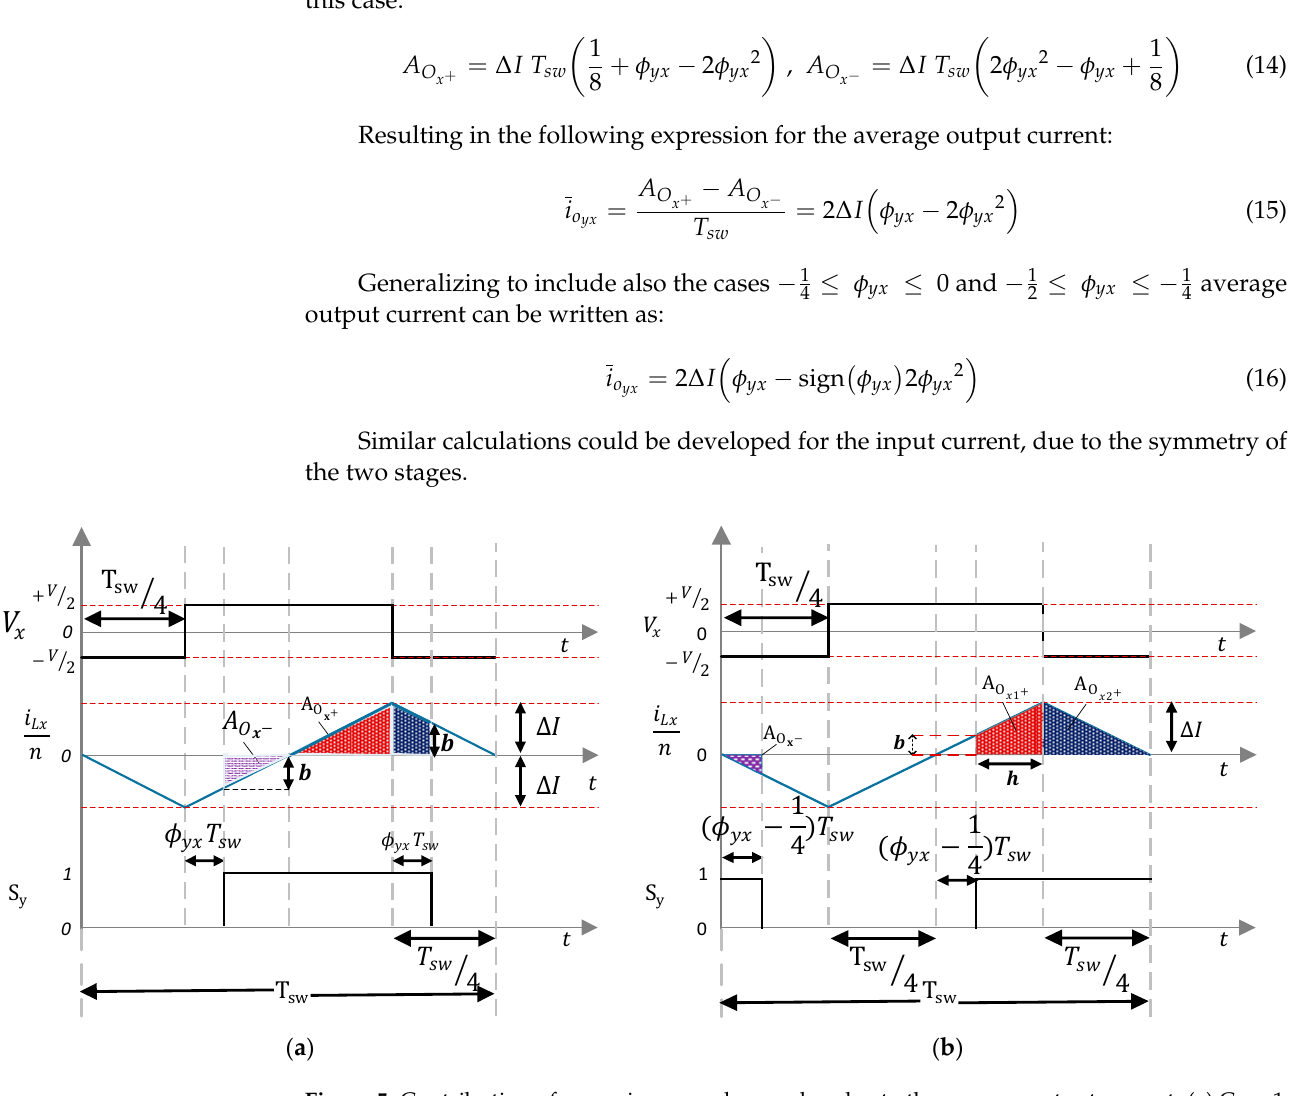
Figure 5. Contribution of one primary and secondary leg to the average output current: ( a ) Case 1; ( b ) Case 2.